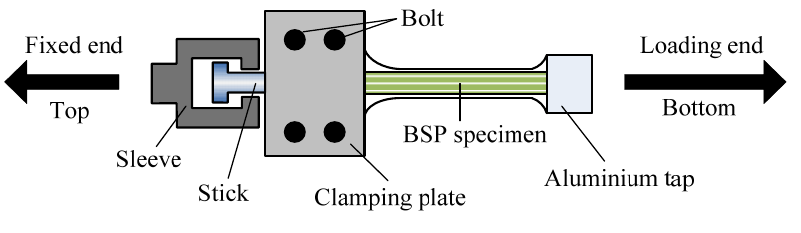
Figure 5. Diagram of the clamping apparatus for the cyclic tensile